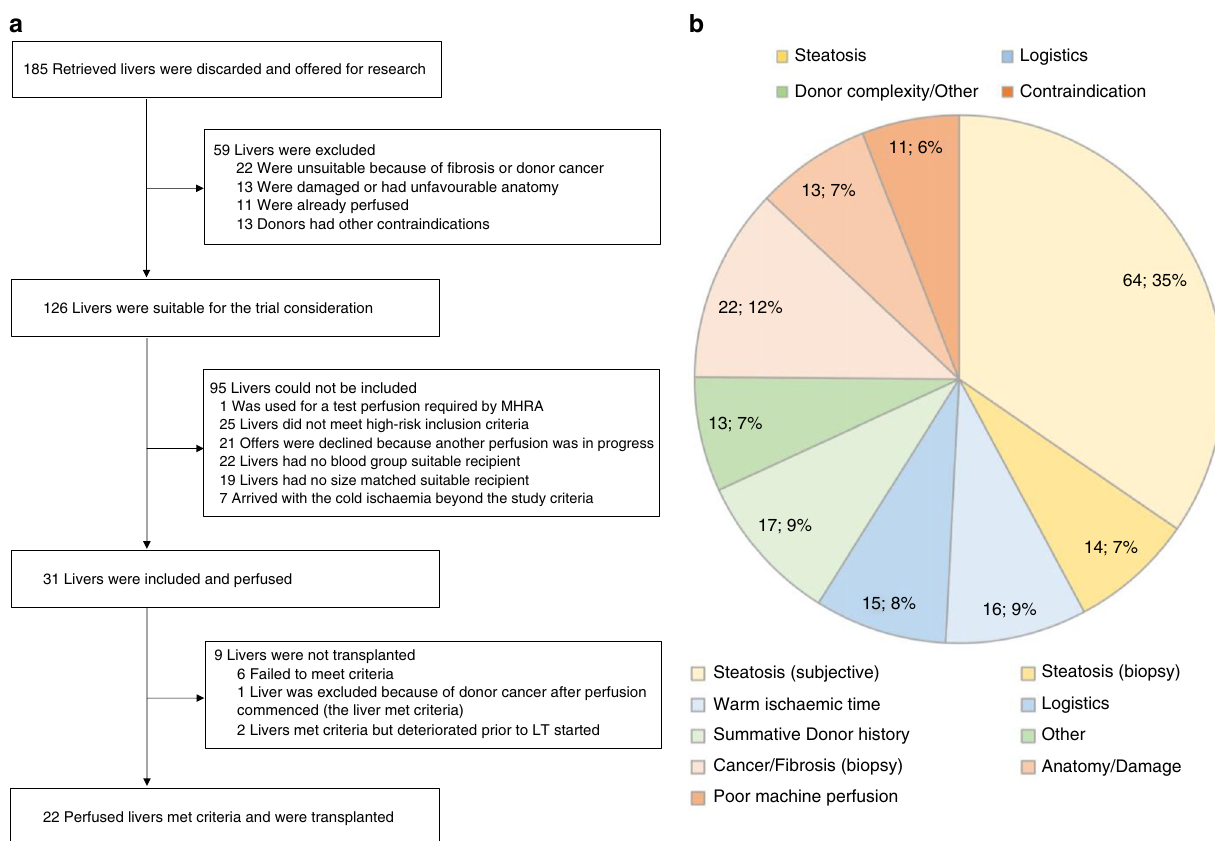
Fig. 1 Information about discarded livers in the UK between November 2016 and February 2018. a The study livers inclusion fl owchart. Over